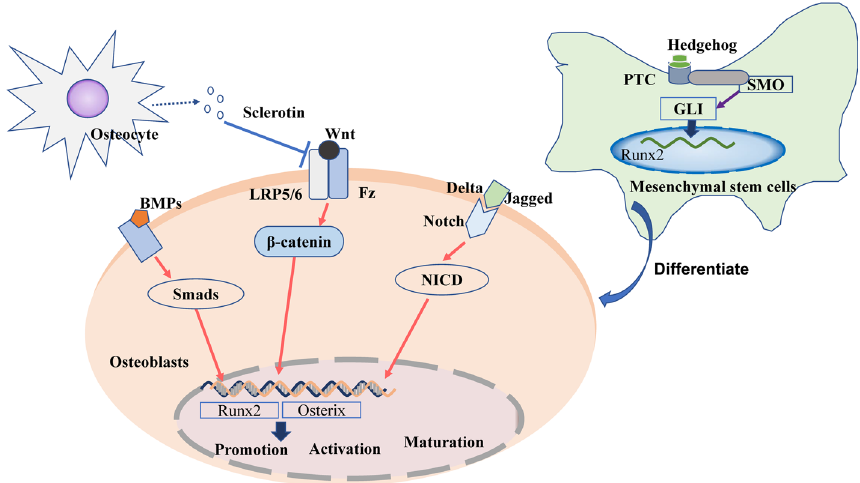
Fig. 3 Signaling pathways regulating osteoblast differentiation and